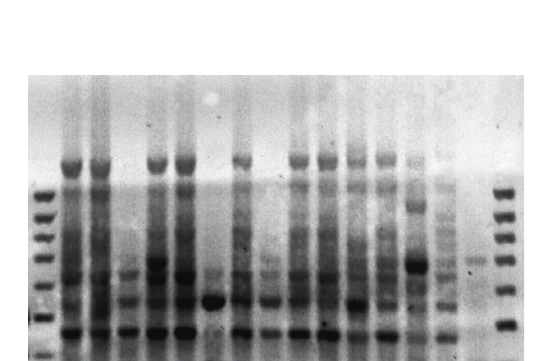
Figure 1: Amplified PCR product using OPC-02 primer.